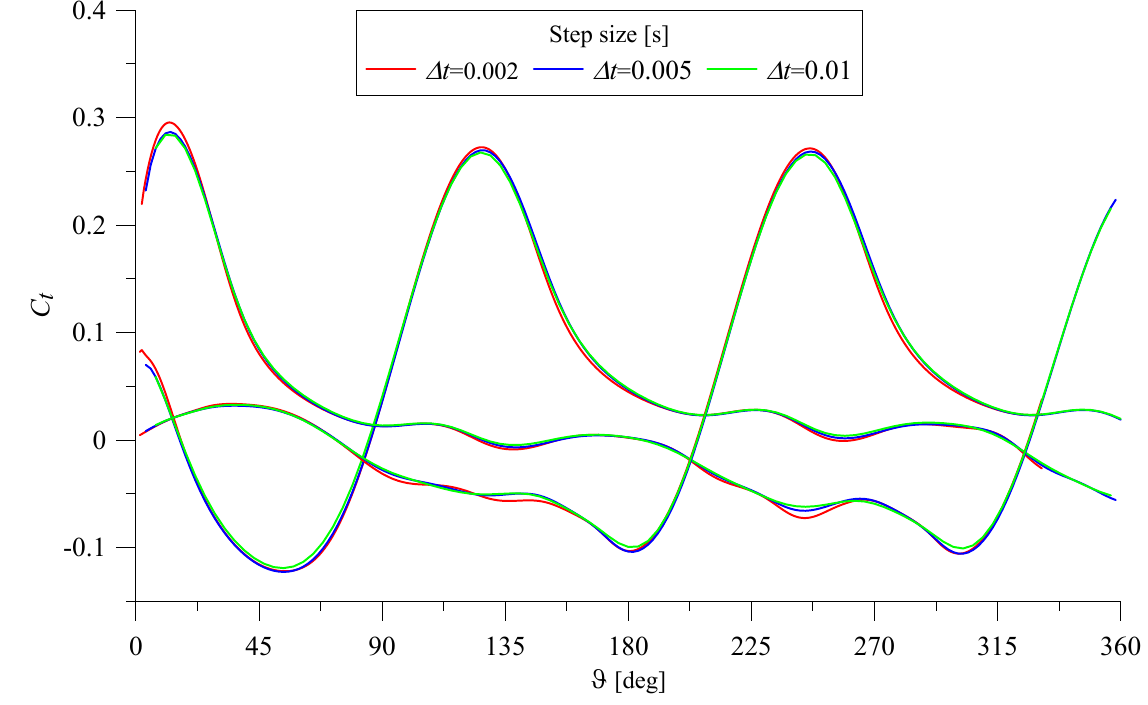
Figure 11. Torque coefficient for different time step